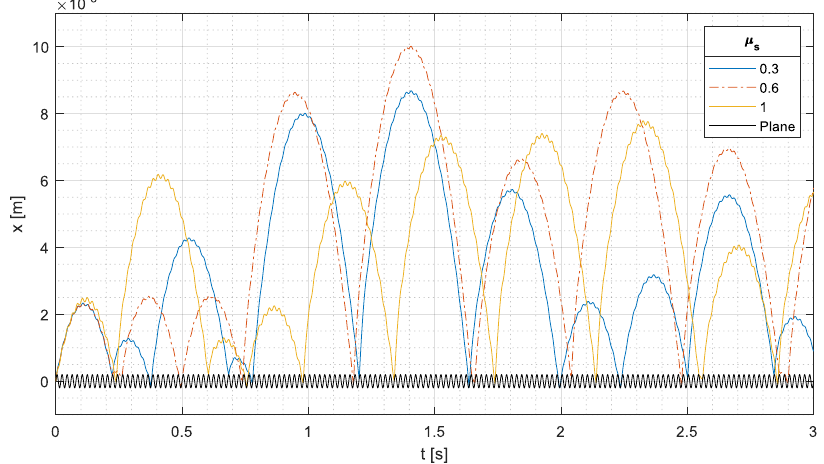
Figure 14. Numerical results, displacement of the cylindrical part along the track, 𝜃 = 3° , 𝜓 = 0 , 𝑓 𝑣 = 0.005 , 𝜇 𝑐 = 0.3, and parametric values of static friction coefficient 𝜇 𝑠 .